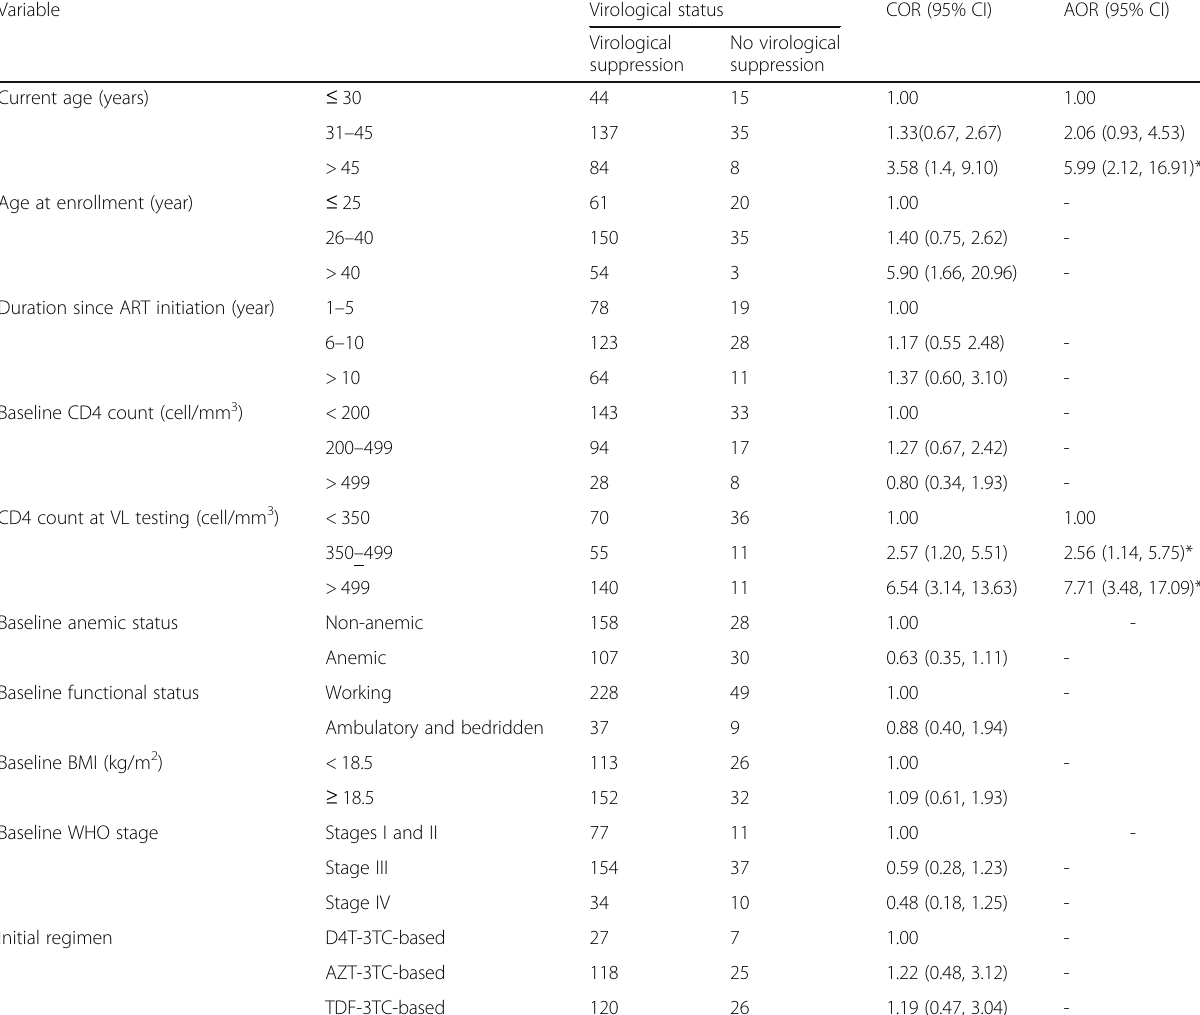
COR crude odds ratio, AOR adjusted odds ratio, ART antiretroviral therapy, CD4 cluster of differentiation 4, VL viral load, BMI body mass index, WHO World Health Organization, HAART highly active antiretroviral therapy *Significantly associated at p value